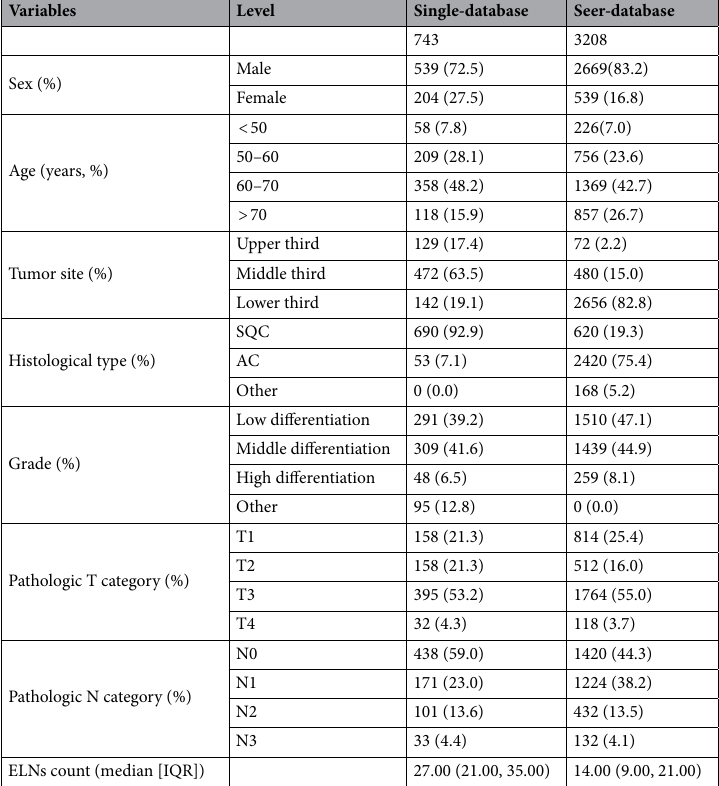
Table 1. Patient Characteristics. SQC Squamous-cell carcinoma, AC Adenocarcinoma, AJCC American Joint Committee on Cancer, ELNs count Examined lymph nodes count, IQR Interquartile